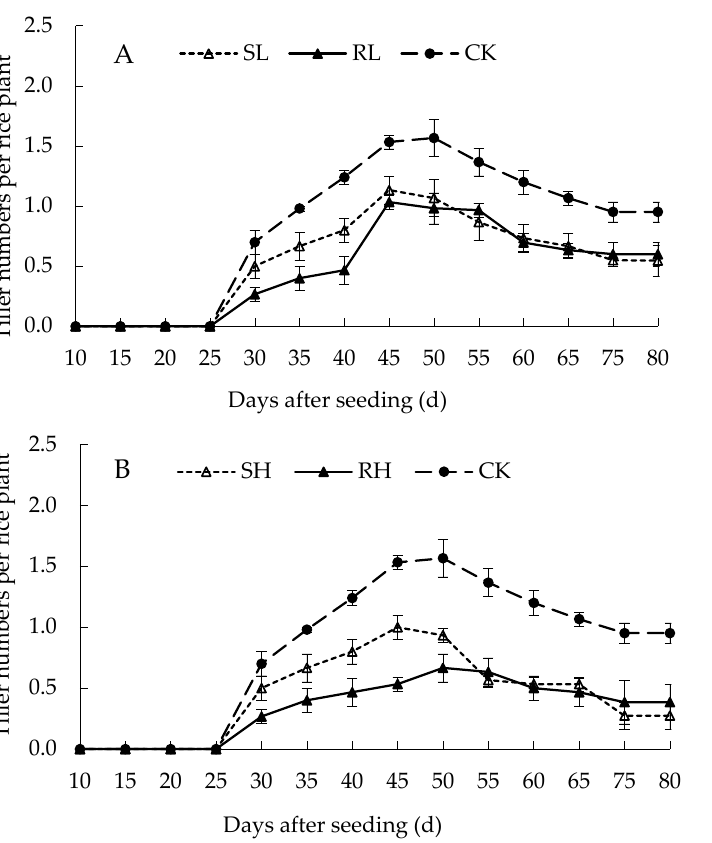
Figure 5. Number of tillers (mean ± standard error) of rice over time at ( A ) a low eared redstem density of 58 plants m − 2 or ( B ) a high eared redstem density of 288 plants m − 2 . The letters L and H refer to low and high densities, respectively. The letters S and R refer to BSM-susceptible and BSM-resistant biotypes, respectively. CK is the control in which only rice was planted. The rice seeding rate was 60 kg ha − 1 in all treatments. Table 1. Effects of two eared redstem biotypes on yield (mean ± standard error) of paddy rice in the greenhouse at 141 DAS. The letters L and H refer to low and high eared redstem densities, respec- tively. The letters S and R refer to BSM-susceptible and BSM-resistant eared redstem biotypes, re- spectively. CK is the control in which only rice was planted. Different letters within columns indi- cate significantly different means ( p < 0.05).